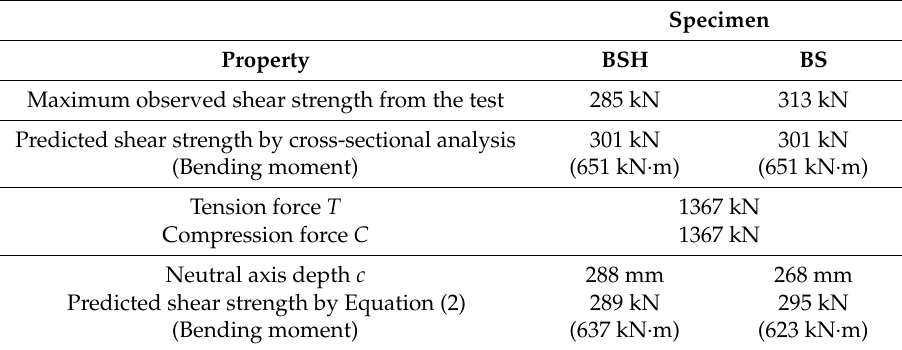
Table 4. Prediction of shear